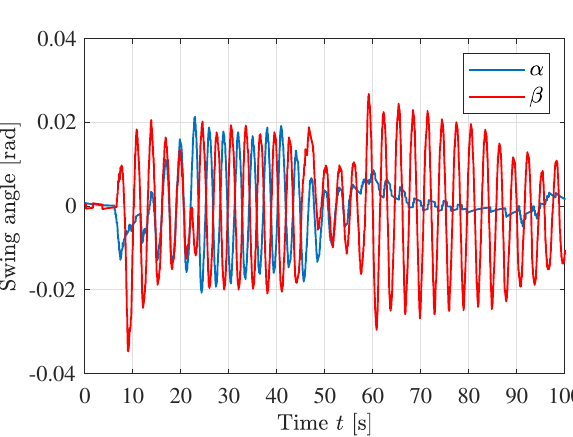
Figure 22: Swing angles without anti-swing control.